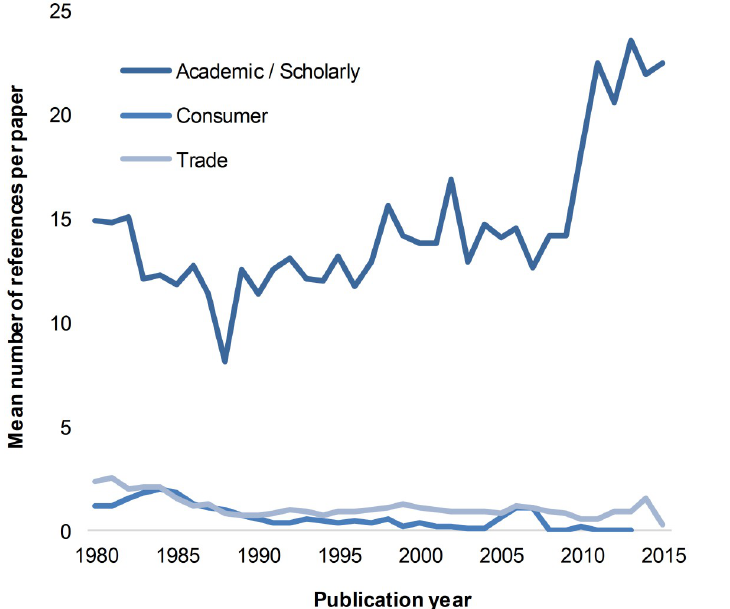
Fig 4. Average number of references per article, by year, 1980–2015.